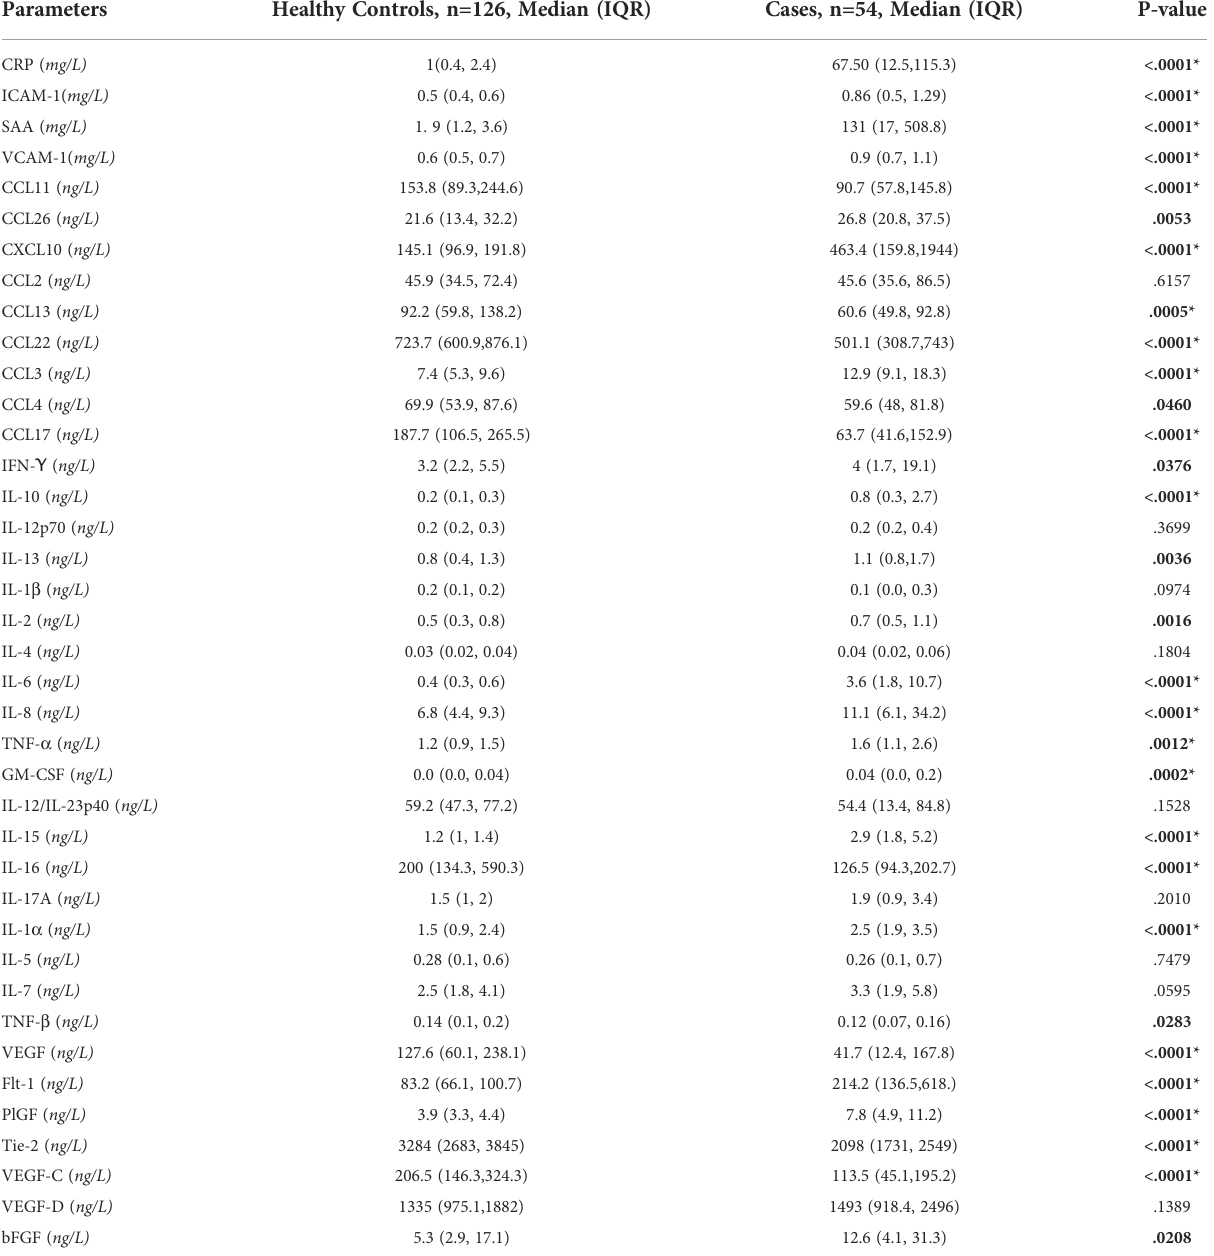
TABLE 5 Concentrations of in fl ammatory biomarkers in healthy controls and cases groups for adjusted age ( ≤ 40 years).